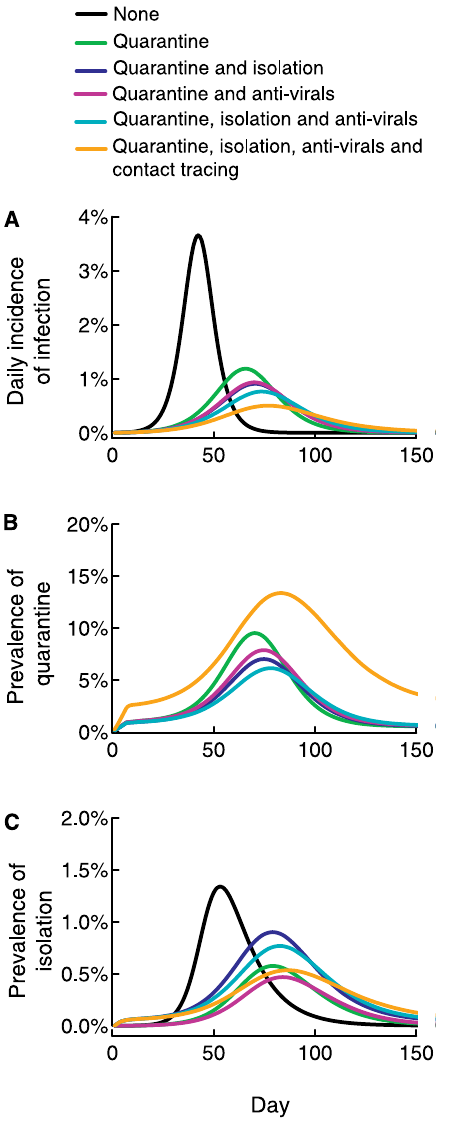
Figure 2. Baseline Transmission (None) and Five Intervention Scenarios: Q, QI, QA, QIA, and QIAC (A) shows the incidence of infection, (B) the percentage of the population living in homes that were quarantined, and (C) the percentage of the population in isolation. We assumed that infectivity within households increased by 100% for each individual who complied with quarantine. For peer groups, quarantine reduced both trans- missibility and susceptibility to 25% of the nonquarantined level. Therefore, the rate of transmission decreased by 75% within a peer group when one of two infected individuals complied with quarantine and by 96% if both did. For the results presented here, we assumed a compliance rate of 50% (see Methods). If individuals complied, they were not infectious to the wider community. When anti-viral treatments were used they reduced susceptibility to 30% of its baseline value and transmissibility to 69% of its baseline value. These are the conservative bounds of the 95% confidence intervals from analyses of clinical trial data for oseltamivir [8]. Results presented here are averages of 100 realizations in a population of 1,000,000 individuals, but there was no significant change for populations of 500,000 or 2,000,000. The 95% stochastic prediction intervals (not shown) do vary with population size, but are narrow (less than 5% deviation from mean values) for simulations in populations of